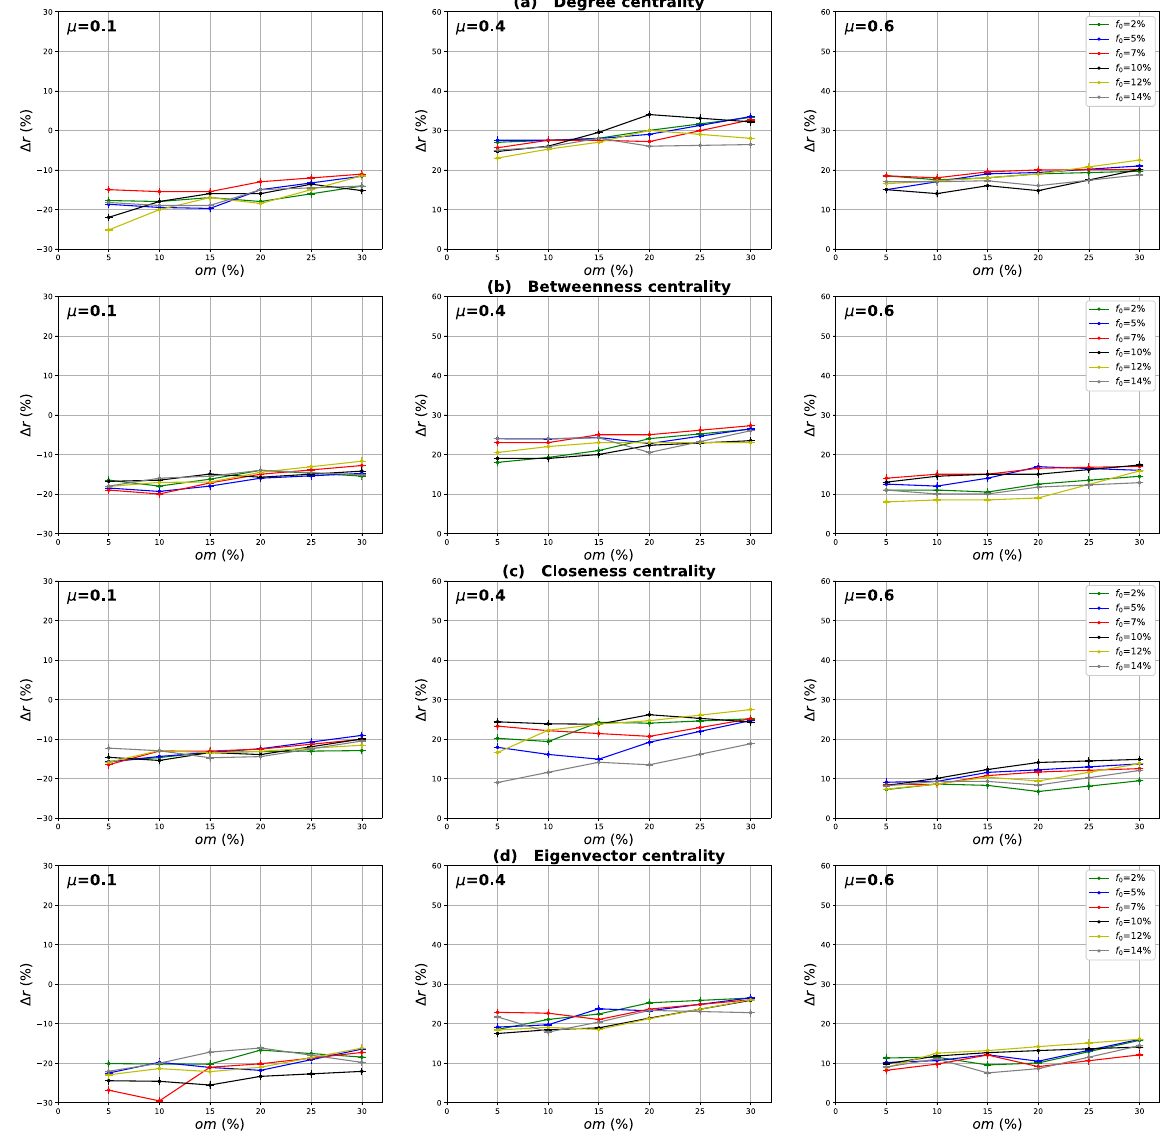
Figure 14. Influence of the community membership degree. The relative difference of the outbreak size Δ r between the standard measure and the Global measure versus the membership degree om . The number of overlapping nodes value on is equal to 10% of the total number of